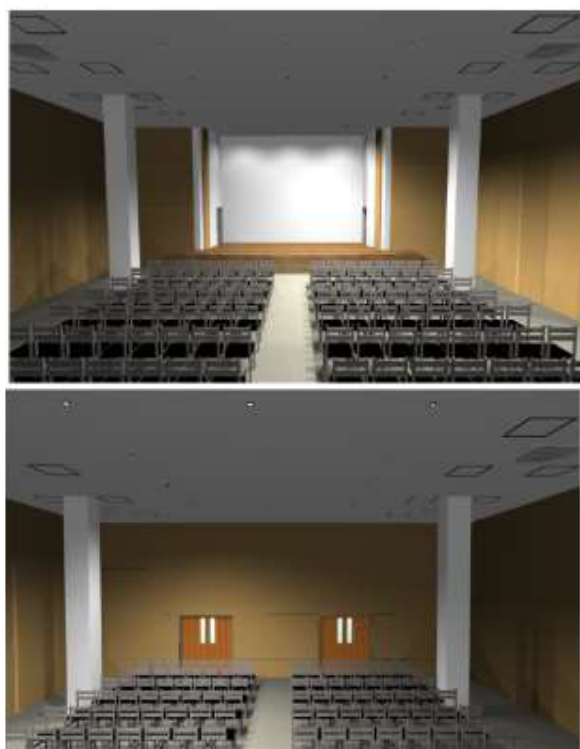
Figure 14. 3D model of Interior in Koica (Hall) (LOD 4) Library – Point Cloud